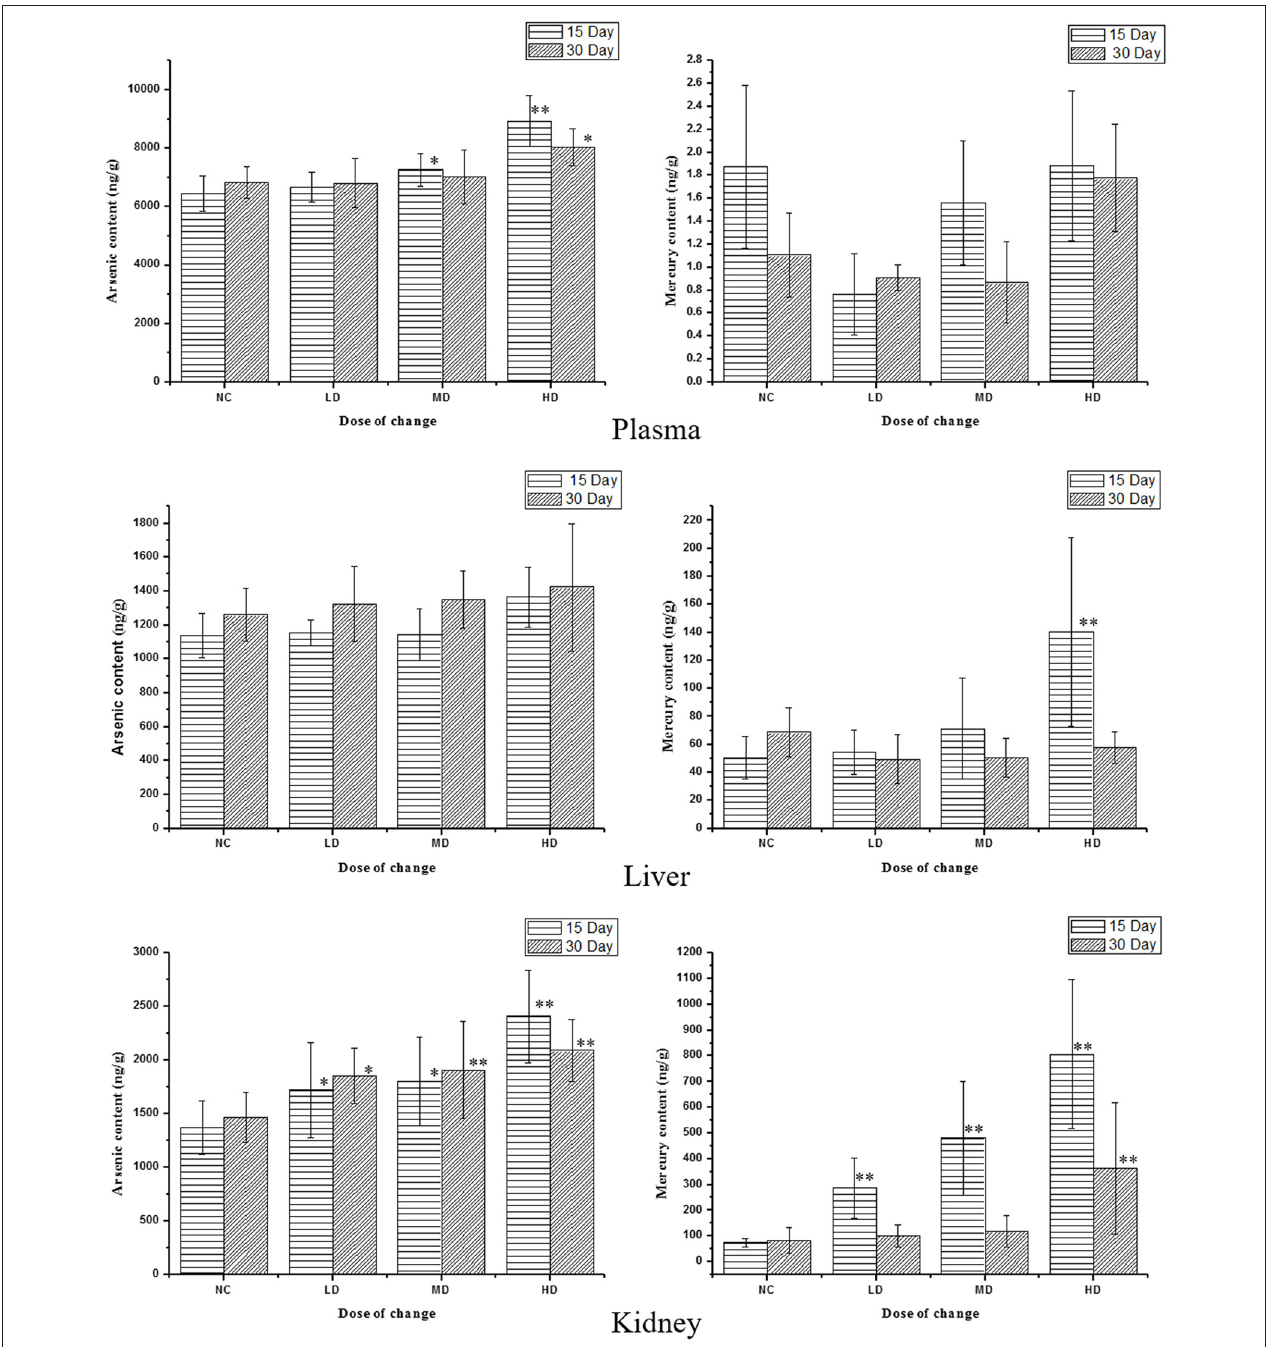
FIGURE 8 | Content of As and Hg in rats serum and tissue samples on various doses. * p < 0.05, ** p < 0.01 vs. control